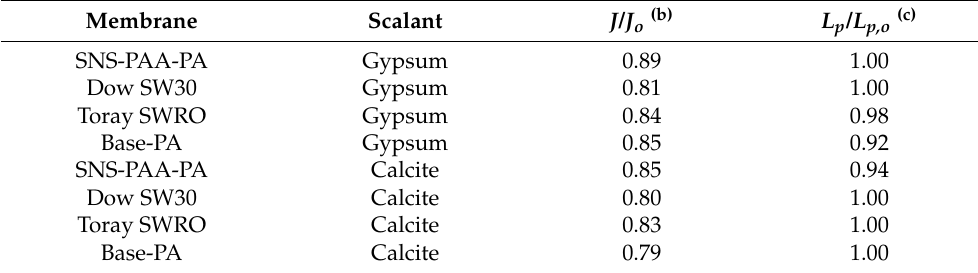
Table 3. Summary of membrane gypsum and calcite scaling and cleaning tests (a) .